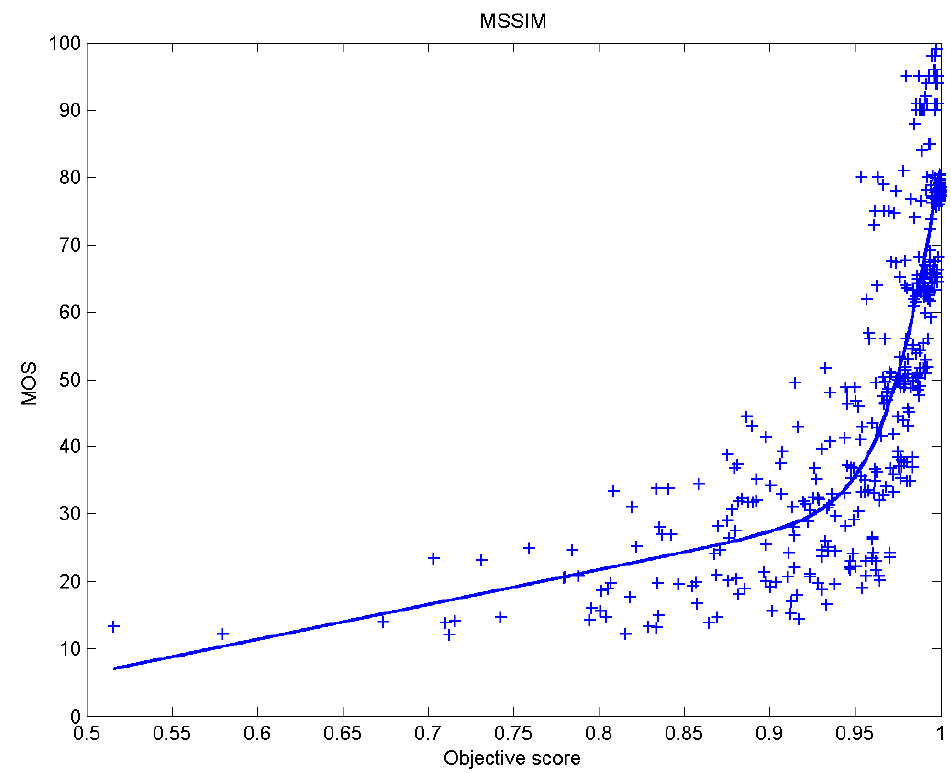
Figure 16. Scatter plots of the subjective scores (MOS) vs. MSSIM.